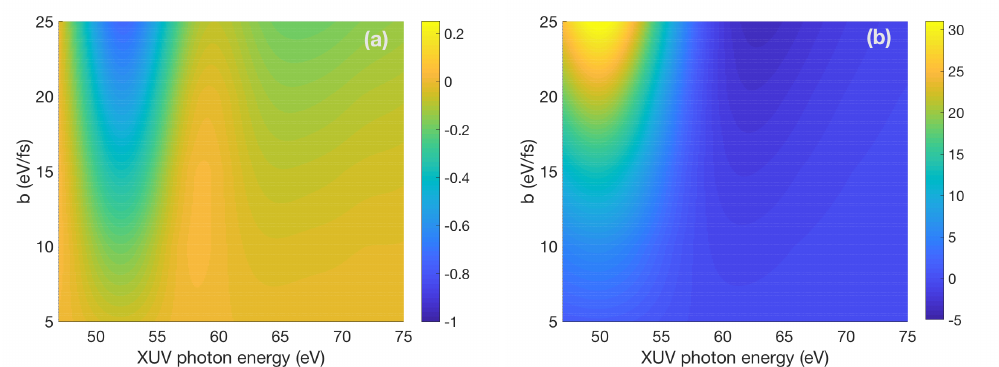
Figure 6. Difference between streaking time delays ∆ t s ( b ) − ∆ t s ( b = 0 ) (in attoseconds) in a chirped to those in an unchirped pulse for photoemission from ( a ) 2 p shell of neon atom and ( b ) 3 p shell of argon atom as function of electron energy and chirp